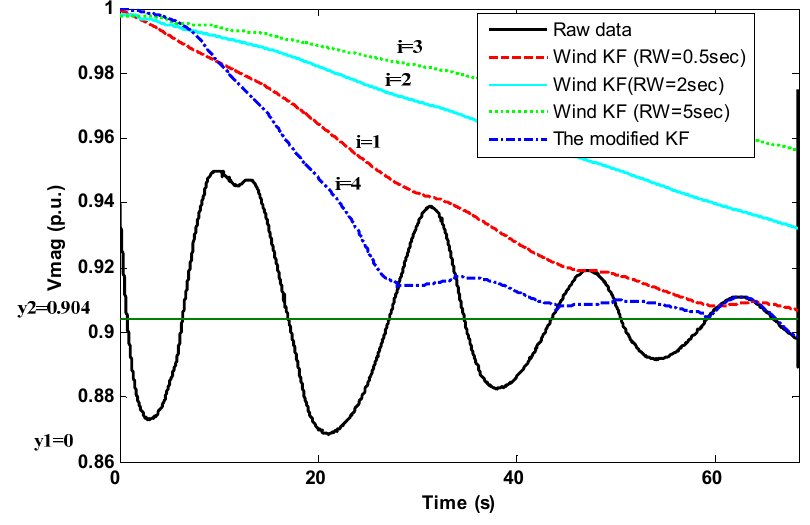
Figure 11. Performance analysis for voltage magnitude signal.